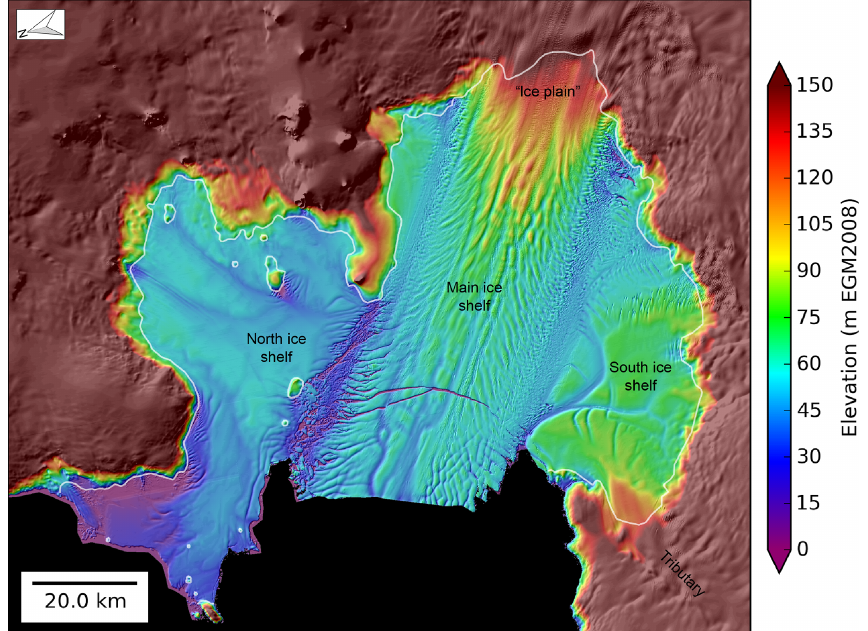
Figure 3. October–December 2012 WorldView/GeoEye DEM mosaic of the PIG ice shelf. Labels show regions discussed in text: North ice shelf, South ice shelf, Main ice shelf, “ice plain”, and fast-flowing South ice shelf tributary. White outline shows ∼ 2011 grounding line. Elevation values are the corrected surface height (Eq. 1) above the EGM2008